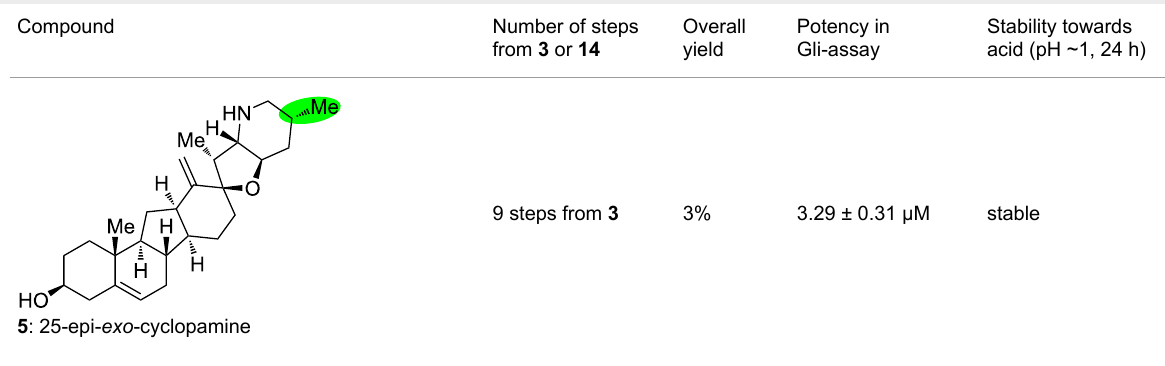
Table 1: Synthesized exo -cyclopamine derivatives, number of steps, yields, results of their biological testing, and stability towards acid.